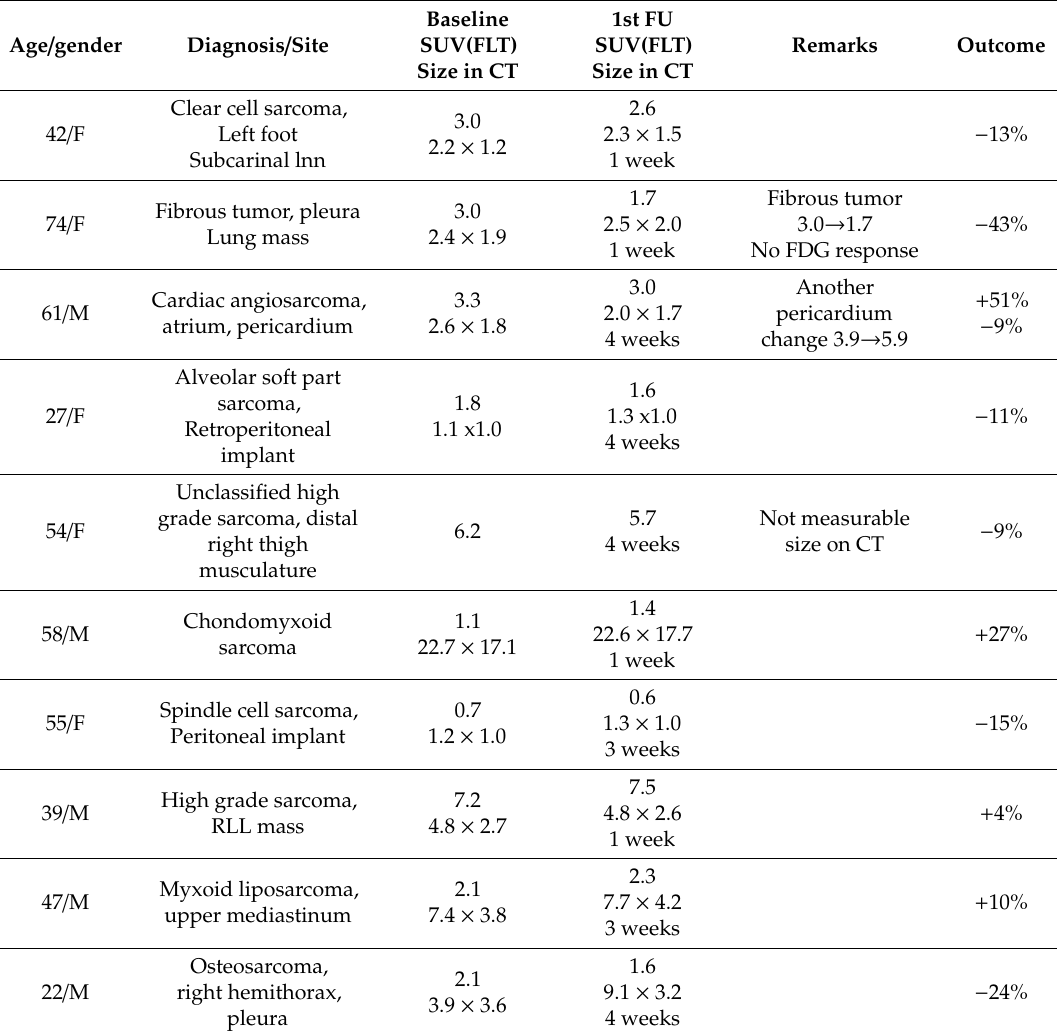
Table 2. The early FLT PET kinetics at 1–4 weeks in patients with sarcoma treated with c-met and mdm-2